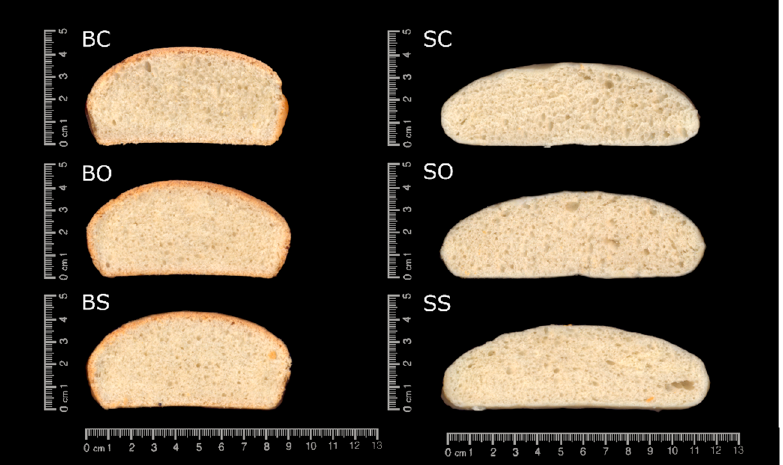
Figure 1. Cross section of breads. Baked control bun made with margarine (BC); baked bun made with olive oleogel (BO); baked bun made with sunflower oleogel (BS); steamed control bun made with margarine (SC); steamed bun made with olive oleogel (SO); steamed bun made with sunflower oleogel (SS).